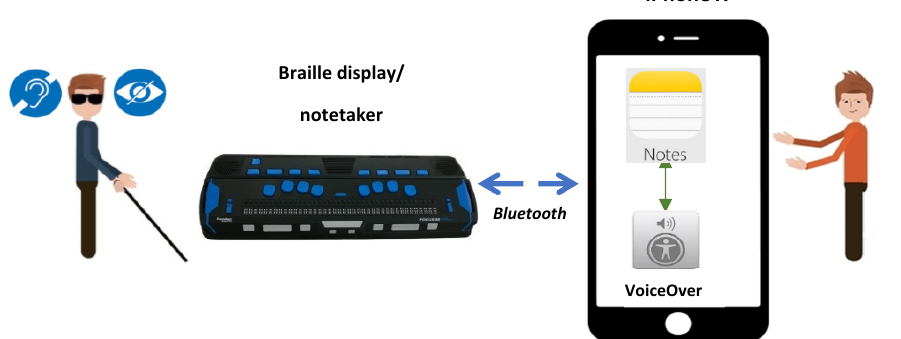
Figure 2. Solution for face-to-face communications of people with deafblindness, from [18] (p. 1). Braille display used was the Focus 40 Blue 5th gen (14.5 × 3 × 0.75 po, 1.24 lbs, $3295 USD). Copyright © Freedom Scientific Inc. Clearwater, United States and Barendrecht, The Netherlands. It is a black braille keyboard with the 8 dots in color blue, 40 cells, and